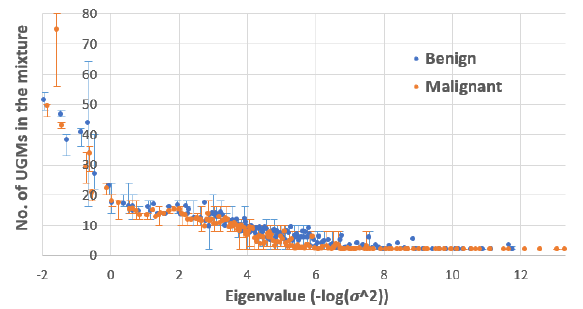
Figure 1. Number of UGMs in the mixture in each projected dimension with different